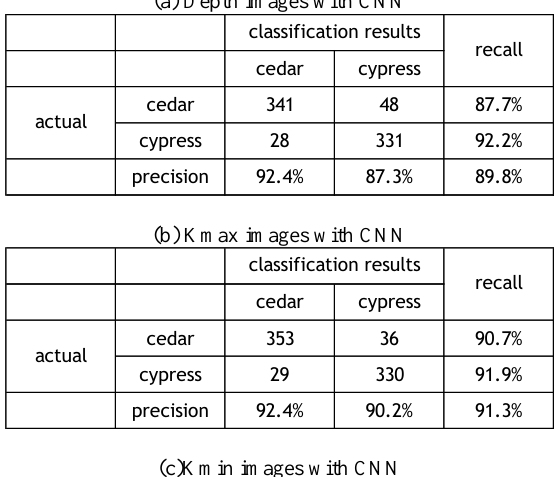
92 . 4 % 90 . 2 % 91 . 3 (c)Kmin images with CNN